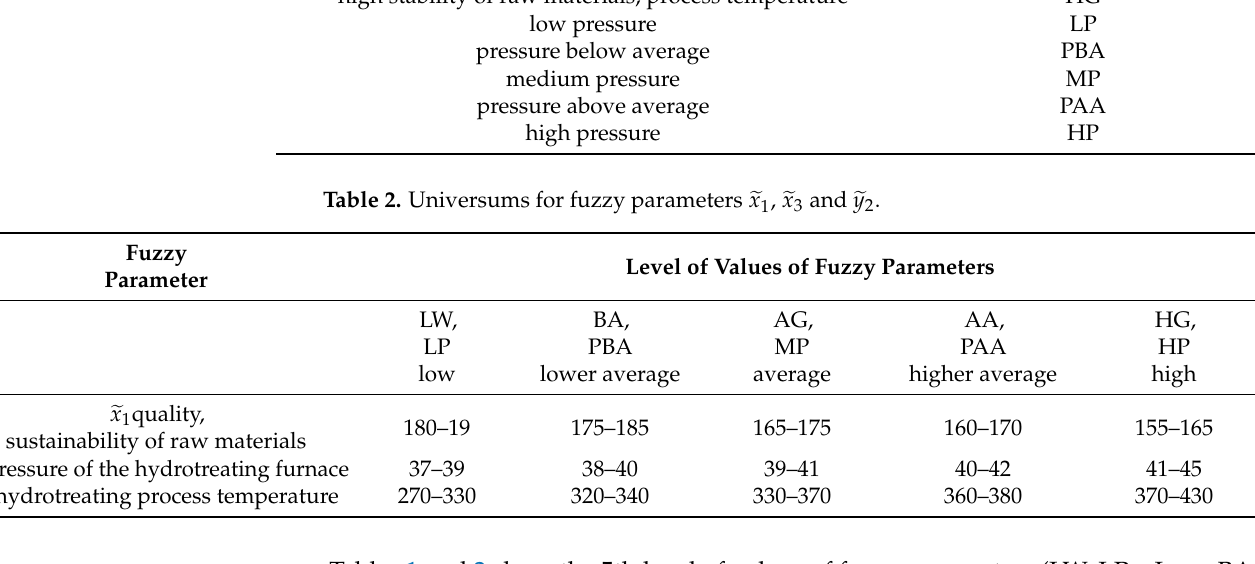
Table 2. Universums for fuzzy parameters